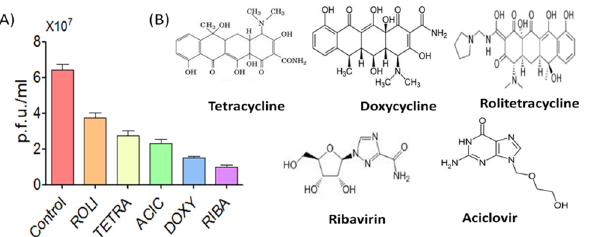
Fig 1. The inhibitory effect of antimicrobial agents against CHIKV replication in Vero cells. (A) Viral load was significantly reduced after the treatment with TETRA derivatives and the antiviral drugs compared with the untreated CHIKV-infected cells. DOXY showed highest inhibitory effect against CHIKV replication in Vero cells compared to the control, ROLI and TETRA. RIBA showed higher inhibitory effect (p < 0.01) against CHIKV compared to ACIC and other TETRA derivatives except DOXY. (B) The chemical structure of the medical compounds (One way ANOVA, P < 0.01).